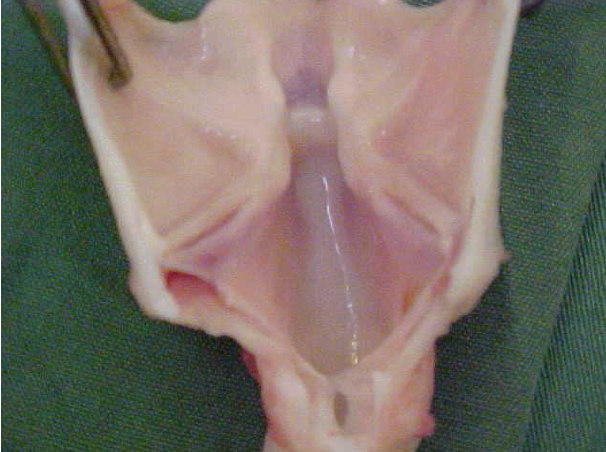
FIGURE 3 – Specimen exposure for surgical removal of vocal